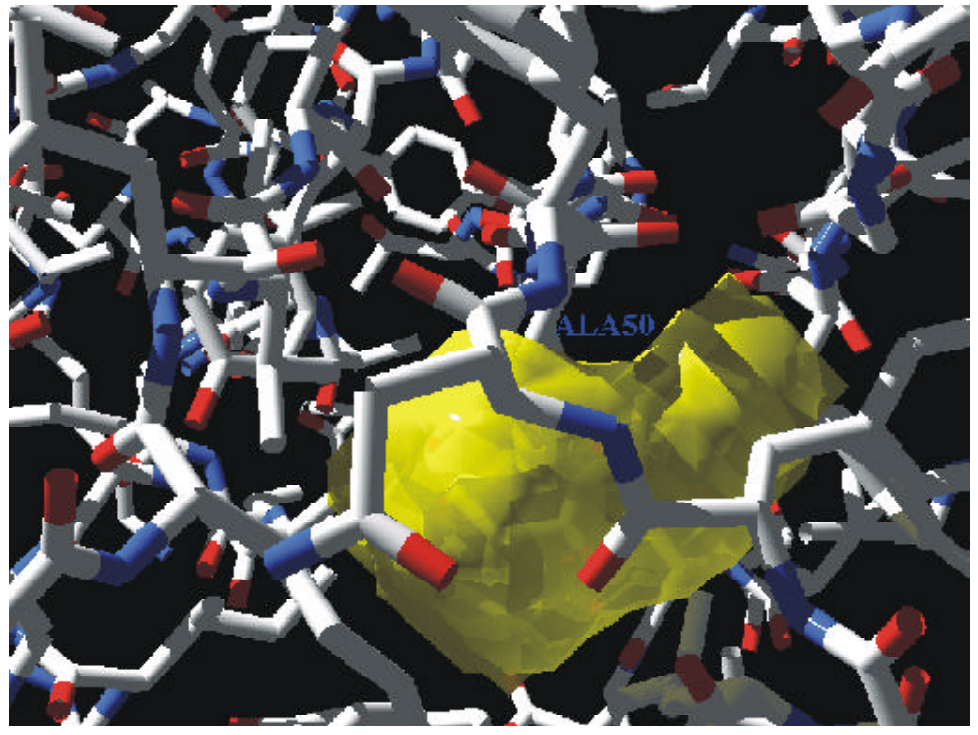
FIGURE 3. Model of the cavity created in wild-type apoflavodoxin by replacing L50 with